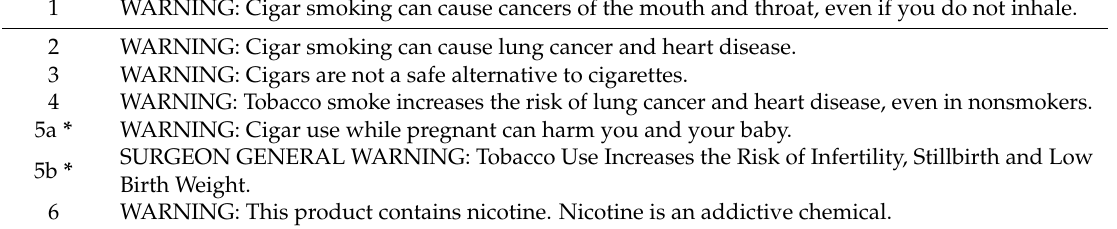
Table 1. Cigar warnings mandated by Food and Drug Administration (FDA) deeming